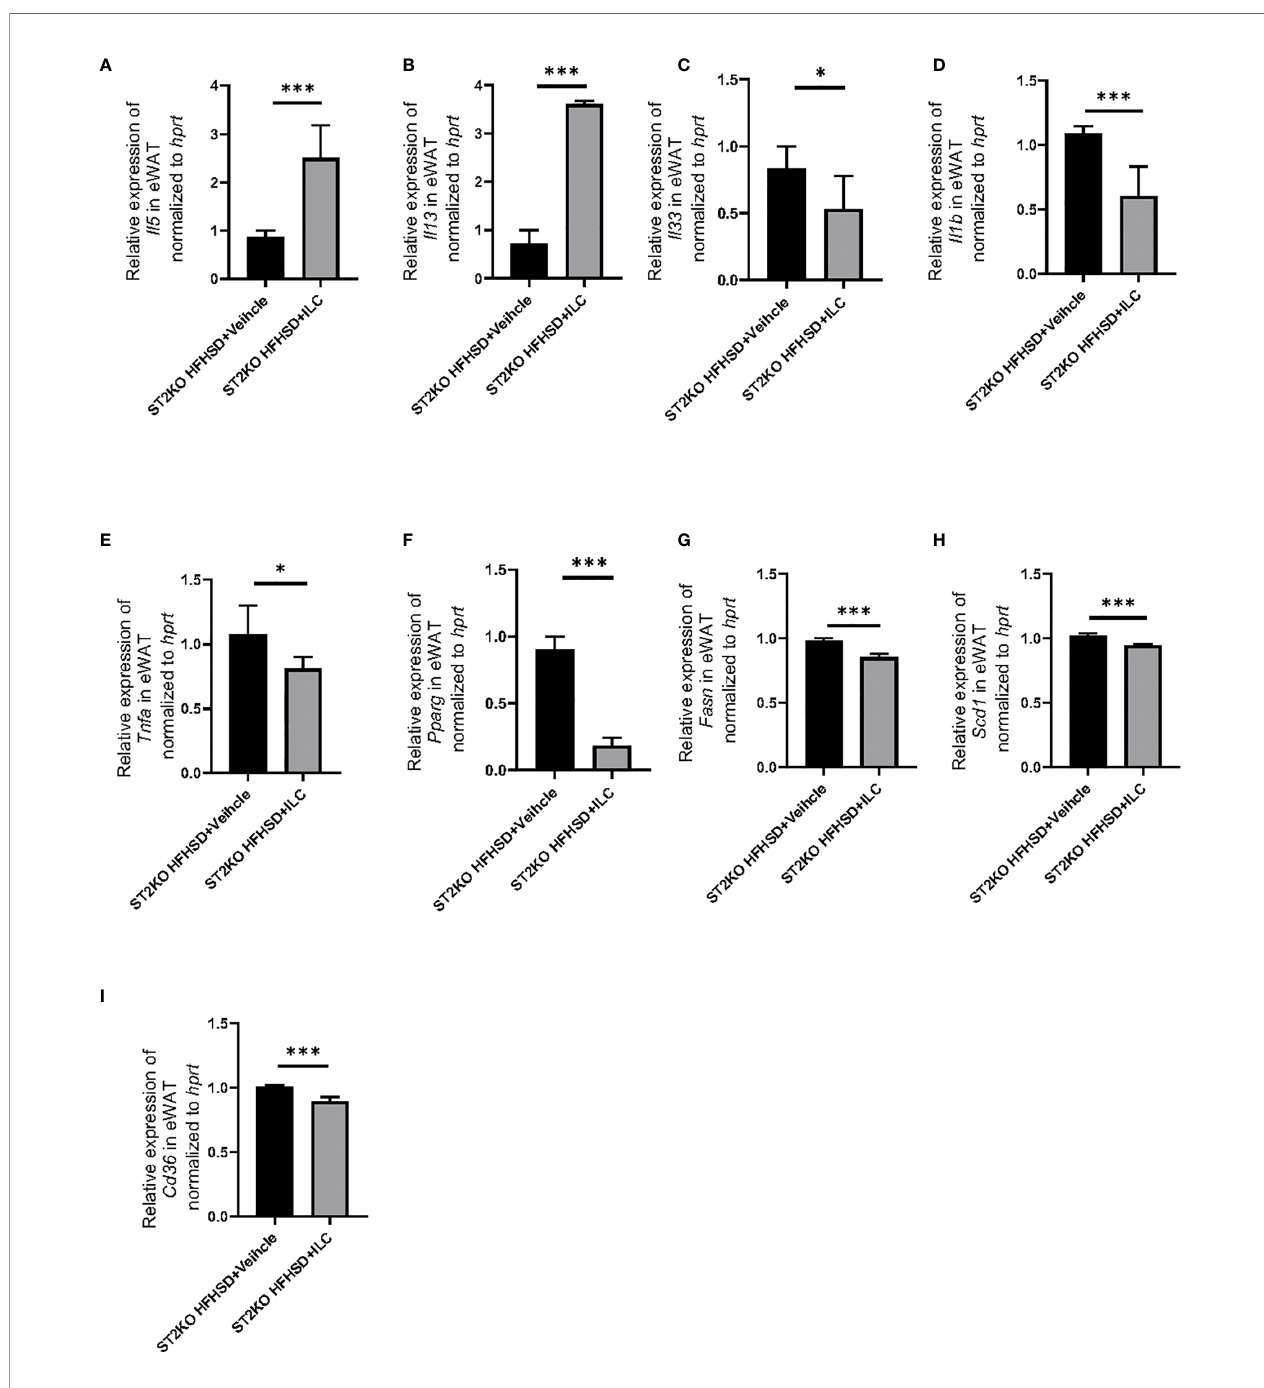
FIGURE 7 | Adoptive transfer of ILCs from WT mice bone marrow decreased the expression of genes related to in fl ammation and fatty acid metabolism in eWAT, The relative expression of mRNA (A) Il5 , (B) Il13 , (C) Il33 , (D) Il1b , (E) Tnfa , (F) Pparg , (G) Fasn , (H) Scd1 , and (I) Cd36 indicated genes in eWAT normalized to Gapdh (n = 6). Data are represented as mean±SD; *p < 0.05, ***p < 0.001 by One-way ANOVA